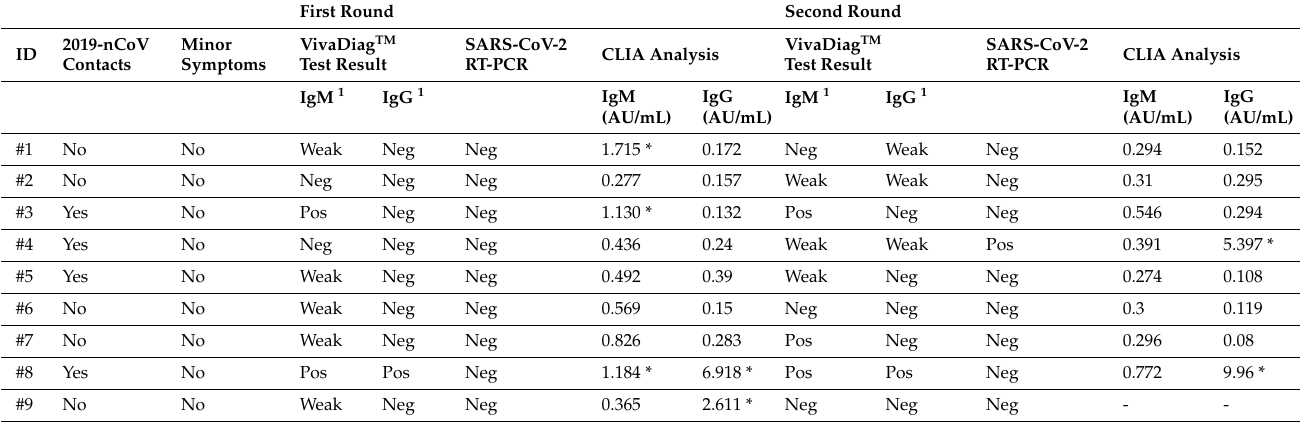
Table 2. Results of VivaDiag TM , RT-PCR and CLIA related to health-care workers with positive VivaDiag TM results during the first